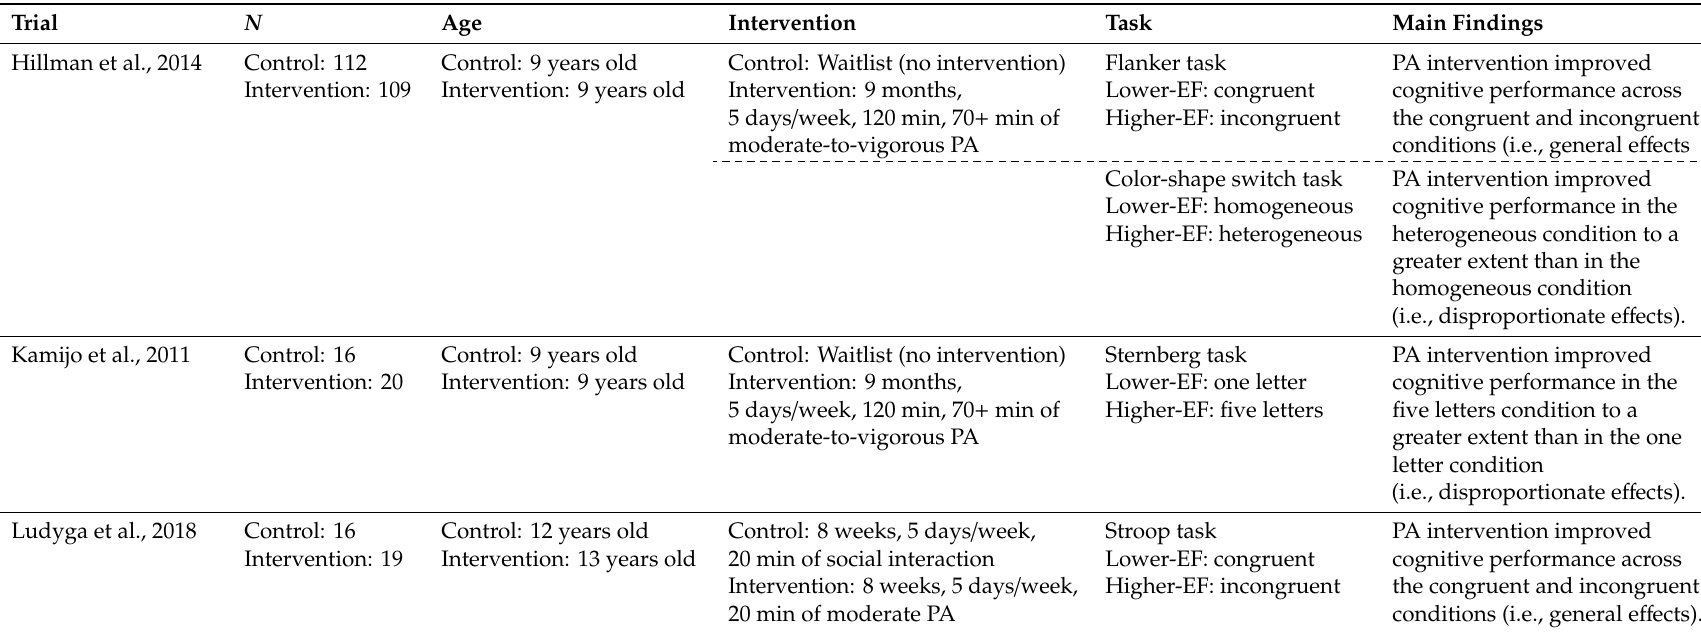
Table 1. Summary of the randomized controlled trials included in this